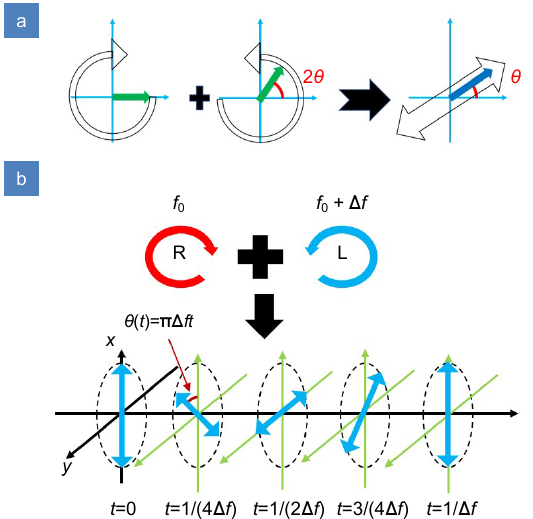
Fig. 1 | Design principle of generating a linearly polarized beams with a rotating polarization angle based on optical het- erodyne interference. ( a ) Linearly polarized beam with angle θ to the x -axis can be generated by superposition of two circularly polar- ized beams with opposite handedness and the phase difference of 2 θ . ( b ) Linearly polarized beam with a rotating polarization angle by superposition of two circularly polarized beams with opposite hand- edness. The polarization angle rotated at frequency of ∆ f /2, where ∆ f is the heterodyne frequency of two laser